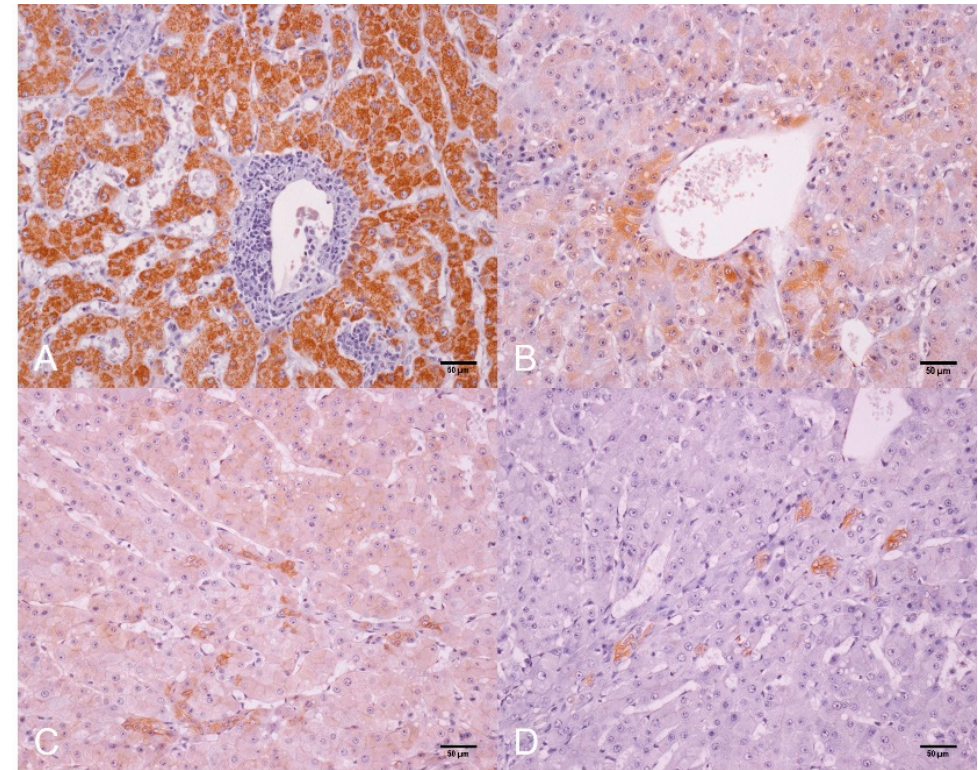
Figure 3. Hepatocellular carcinoma (HCC), liver, three-toed sloth ( Bradypus variegatus ). ( A ) Strong immunostaining of HepPar-1 in the cytoplasm of neoplastic hepatocytes and negative staining in cholangiocytes and inflammatory cells infiltrate. IHC. Bar 50 µm. ( B ) Patchy cytoplasmic immunostaining of GS in neoplastic hepatocytes around the tumor vein. IHC. Bar 50 µm. ( C ) Discrete membranous β -catenin immunostaining in neoplastic hepatocytes and strong positivity in proliferated ducts within HCC lesion. IHC. Bar 50 µm. ( D ) Positive immunostaining for CK19 in biliary duct cells proliferated within the tumor and was negative in neoplastic hepatocytes. IHC. Bar 50 µm. Diaminobenzidine (DAB) chromogen and counterstaining with Harris’ hematoxylin.